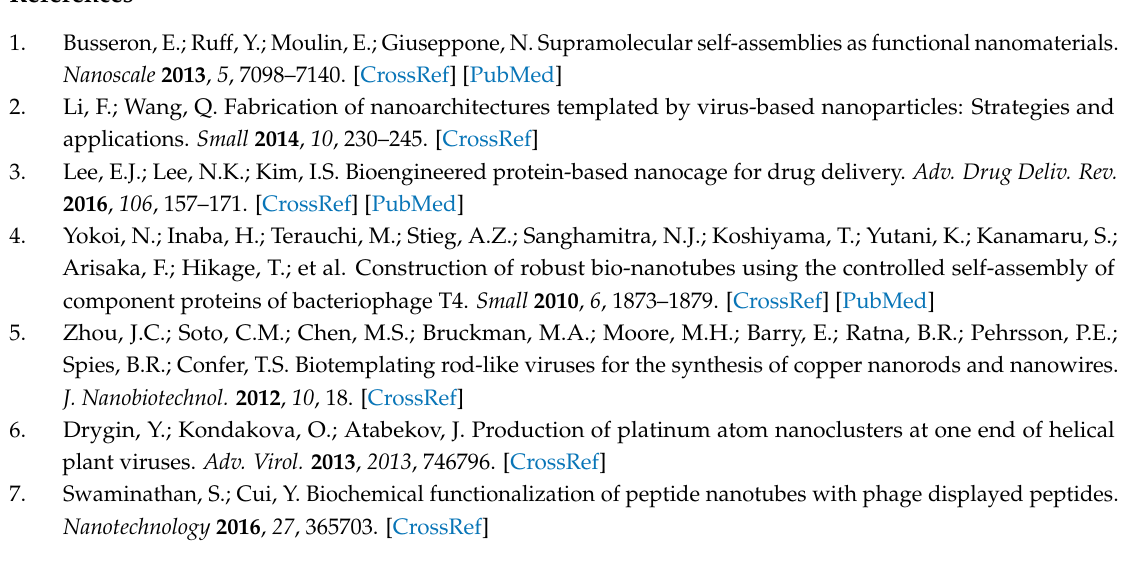
Table S1: Oligonucleotides used in this study; Table S2: Constructs of gp053; Table S3: Homology of gp053 from FV3 with proteins from other bacteriophages; Figure S1: Schematic representation of construction of gp053 oligomers; Figure S2: The protein sequence coverage map obtained from the PLGS-processed MS E data. Author Contributions: R.M., L.T. and E.Š. conceived and designed the experiments; E.Š., L.T., R.R., S.P., K.G. and A.K. performed the experiments; R.M., E.Š. and A.K. analysed the data; R.M. and M.V. contributed reagents/materials/analysis tools; E.Š. and R.M. wrote the paper. Funding: This research was funded by the European Union’s Horizon 2020 research and innovation program [BlueGrowth: Unlocking the potential of Seas and Oceans] under grant agreement No. 634486 (project acronym